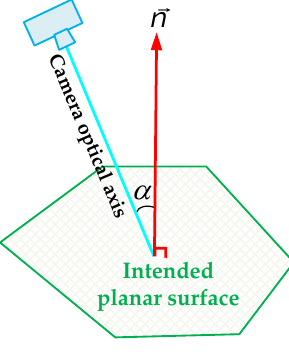
Figure 7. Investigation of the visibility of a planar surface in an image.